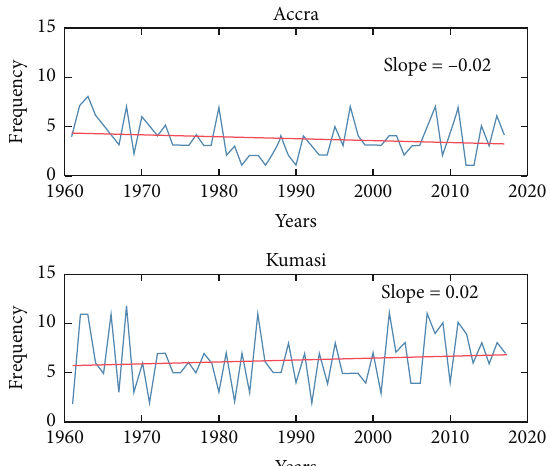
Figure 8: Annual rainfall frequency (ARF). Accra and Kumasi ARF based on the 95th percentile thresholds of 45.10 and 42.16mm, respectively.